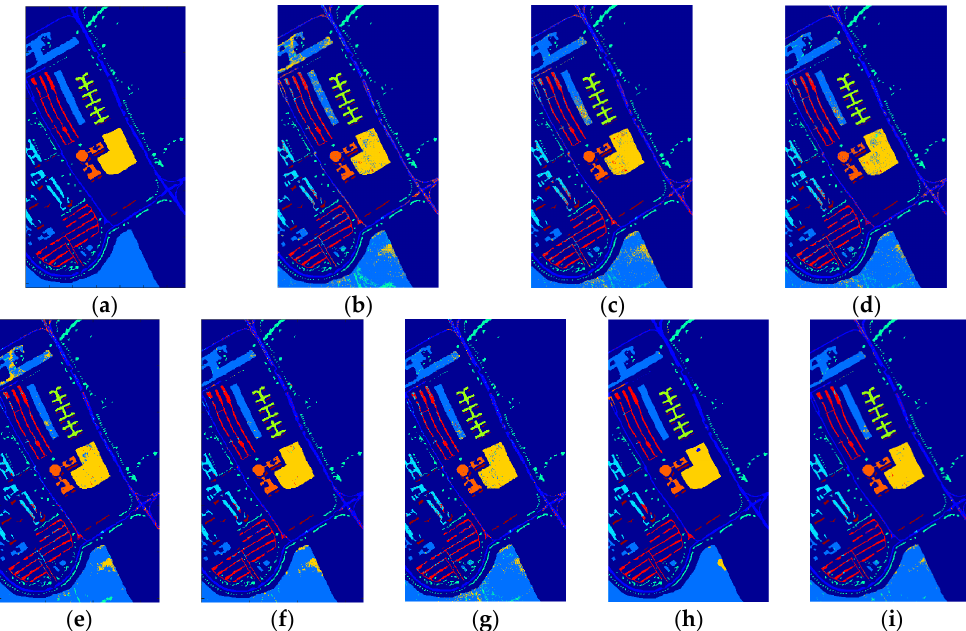
Figure 13. The classification maps obtained via different algorithms in University of Pavia: ( a ) Ground truth, ( b ) SVM, ( c ) RBFNN, ( d ) O_DBN, ( e ) SVM_TFE, ( f ) RBFNN_TFE, ( g ) CNN, ( h ) EFP-G-c and ( i ) the proposed framework.